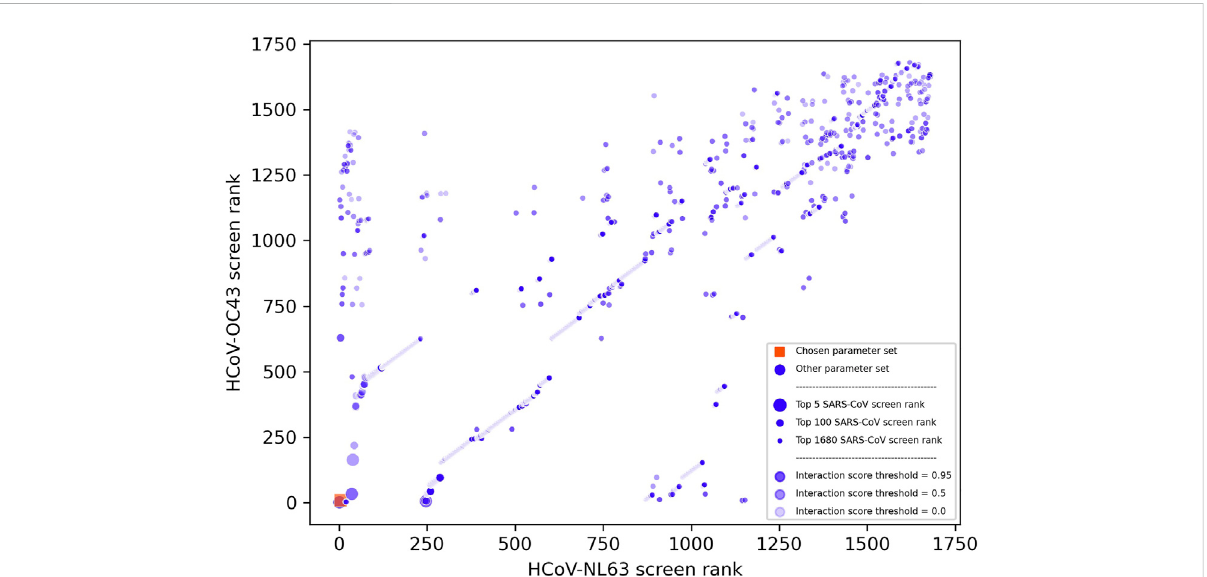
FIGURE 2 Visualizationof parameter optimizationsetranks across threecoronavirusscreens. Thisscatter plotdepictstheranks ofeachsetofparameters for the interaction scoring protocol and de novo candidate generation pipeline within CANDO after using the discounted cumulative gain metric to score how well each corresponding pipeline ranked sets of active compounds against three separate coronavirus species: HCoV-NL63, HCoV- OC43,andSARS-CoV.TheranksfortheHCoV-NL63andHCoV-OC43screensaredepictedalongthehorizontalandverticalaxes,respectively, while the size of the points depicts if the screen against SARS-CoV ranked within the top 5, 100, or 1,680 for each parameter set. The shade re fl ects theinteractionscorethresholdthatwasusedbythe denovo pipelineto fi lterthecandidates,scaledcontinuouslyfrom0.0(lightest)to0.95(darkest). Thechosenparameterset(orangebox)wasthesecondrankedamongallthreescreenswithranksof3,10,and25forHCoV-NL63,HCoV-OC43,and SARS-CoV, respectively, and used an ECFP10 integer based fi ngerprint, dCxP scoring protocol, and 0.9 compound-protein interaction score cutoff. The strong and consistent performance of this parameter set across three different coronavirus species justi fi ed our selection and warranted its use in generating drug candidates to inhibit SARS-CoV-2.